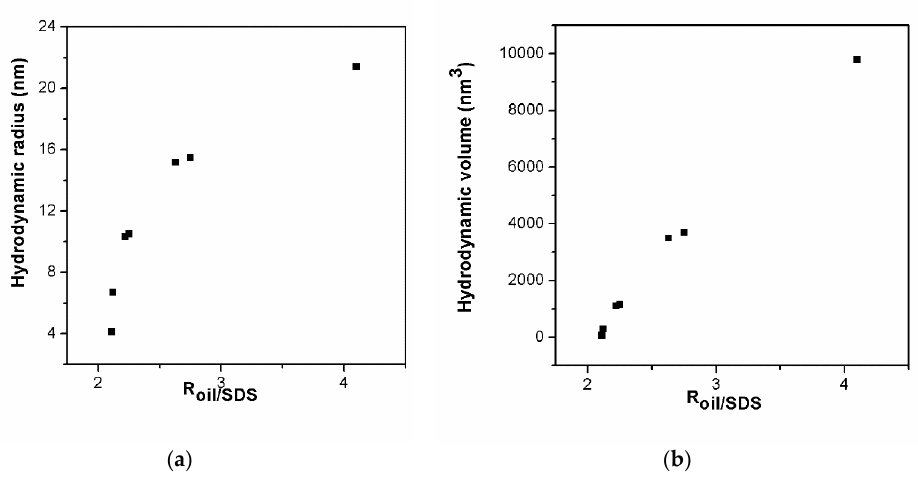
Figure 1. ( a ) Hydrodynamic radius; ( b ) Hydrodynamic volume of prepared microemulsions.